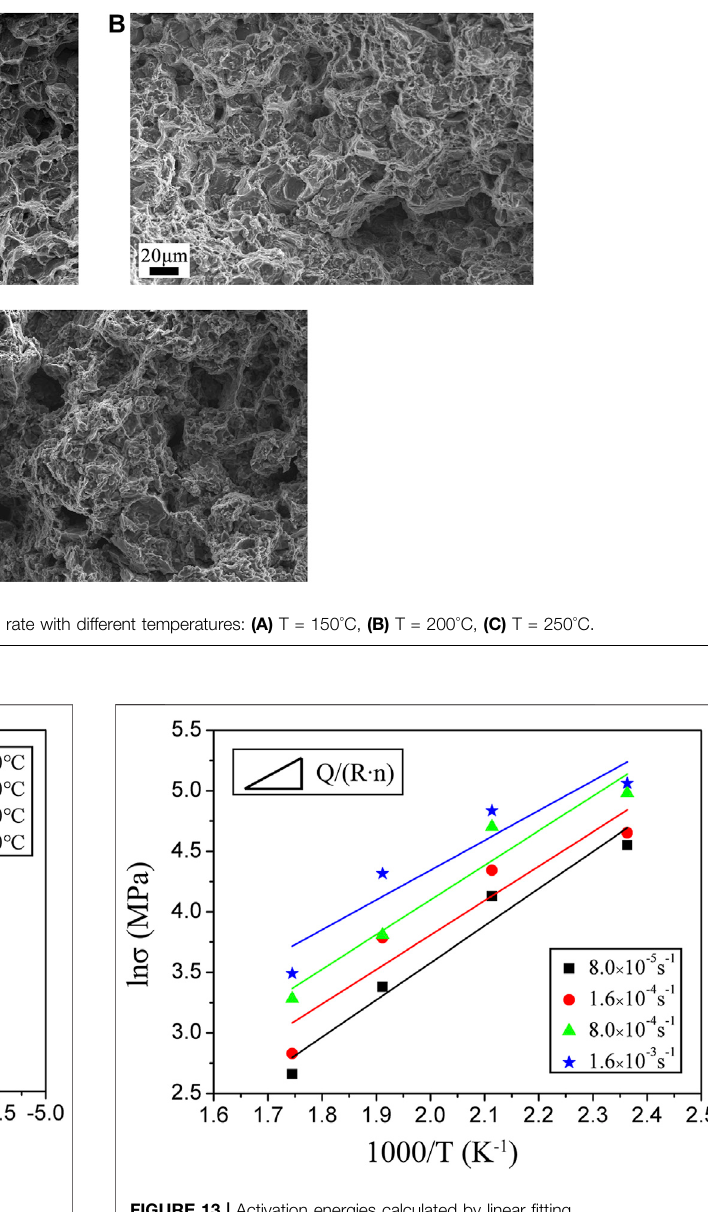
FIGURE 13 | Activation energies calculated by linear fi